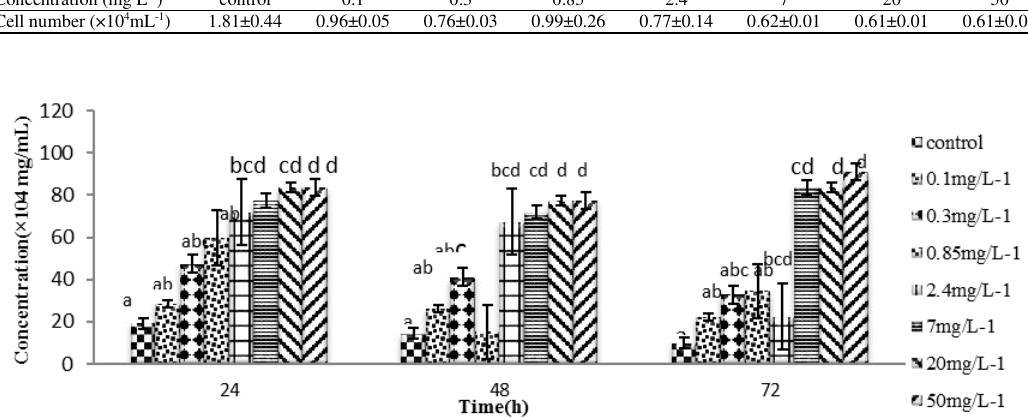
Fig. 1. Specific growth rate of Dunaliella salina after exposure to SiO 2 NPs Notes: Treatments with at least one commonality are statistically significant ( p <0.05).